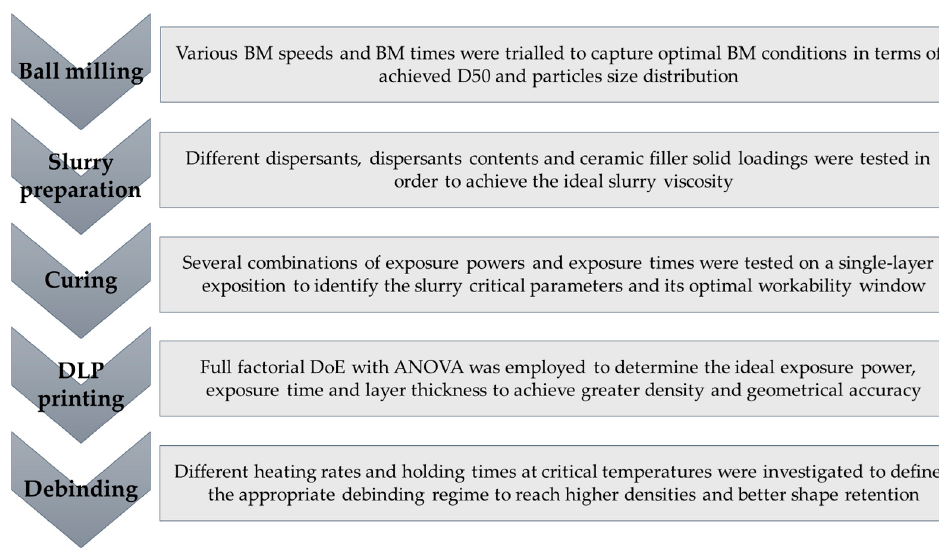
Figure 2. Schematics of the whole experimental campaign.